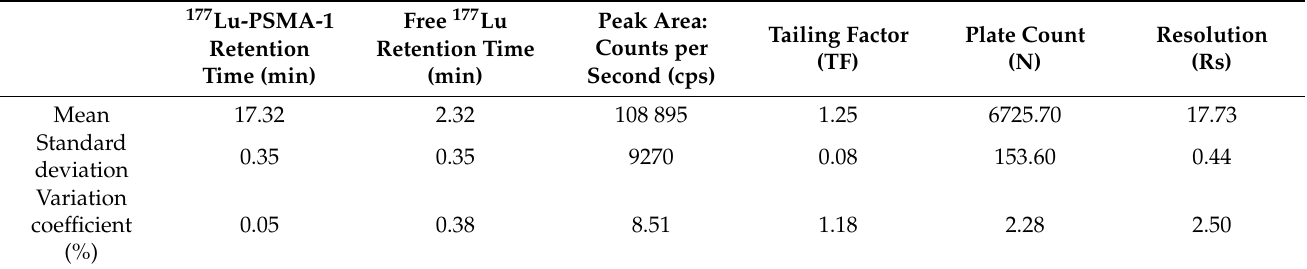
Table 1. Retention time 117 Lu-PSMA, retention time for free 177 Lu impurity, peak area, tailing factor, plate count and resolution in HPLC.